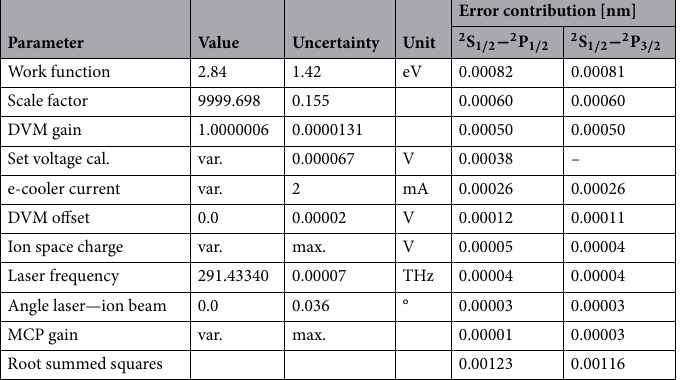
Table 1. Contributions of the individual systematic uncertainties to the overall error budget. A variable parameter is labeled ‘var.’. If the uncertainty of a parameter is labeled ‘max.’, the corresponding contribution to the error budget of the wavelength has been estimated by omitting the correction from the analysis.